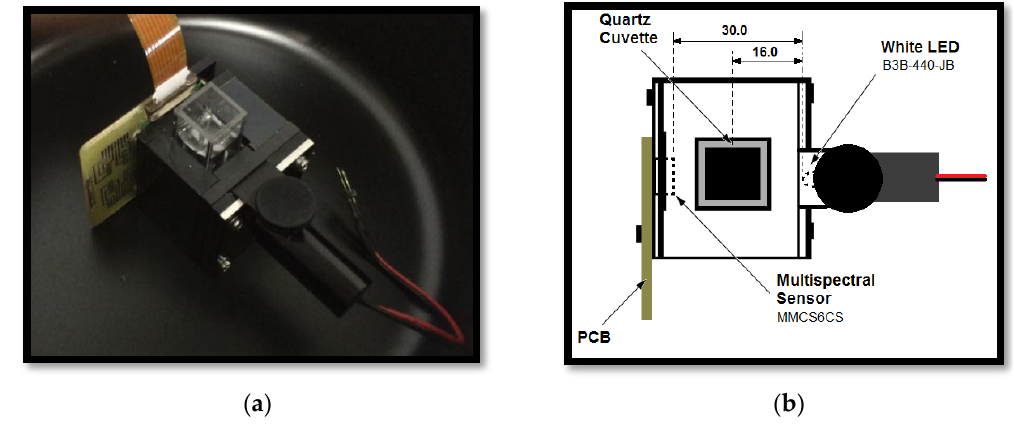
Figure A7. ( a ) Picture of the portable system with the detection sensor MMCS6CS set at the front of the source of a white light-emitting diode (LED). ( b ) Schematic representation of the portable system.